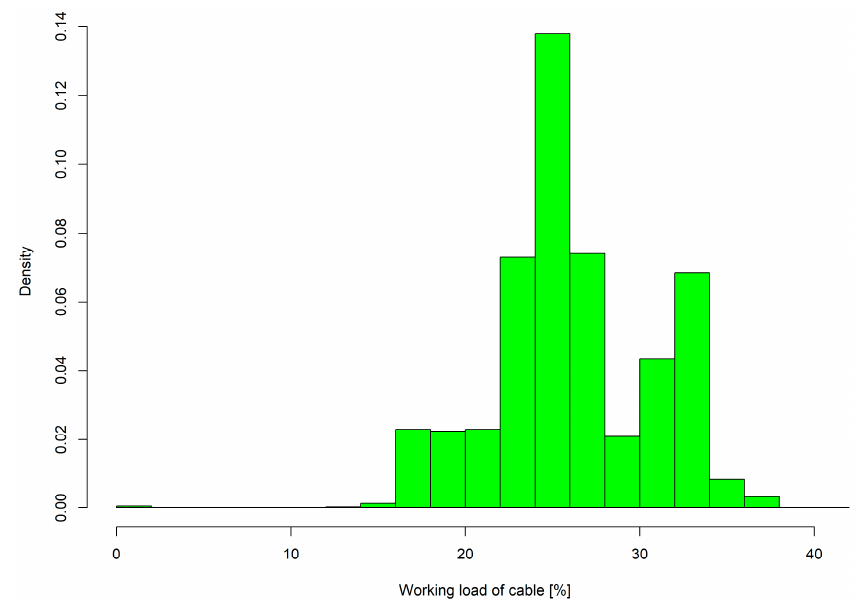
Figure 8. Working load of the cable used during harvesting activities for all captured data.